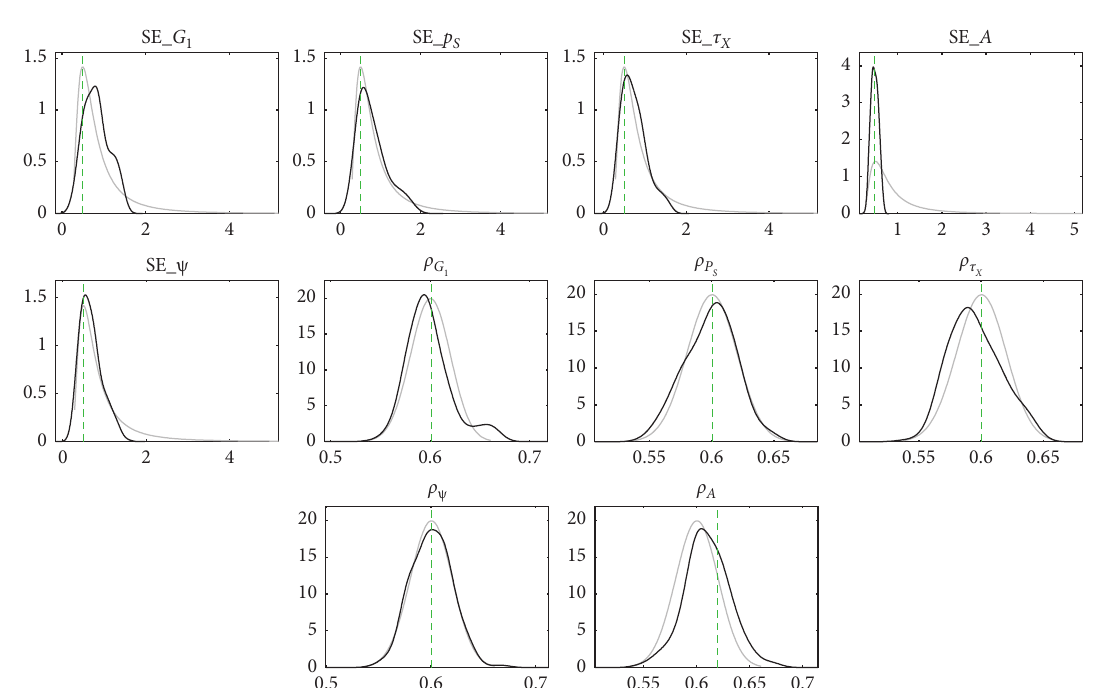
Figure 2: Prior and posterior distribution diagrams in Bayesian